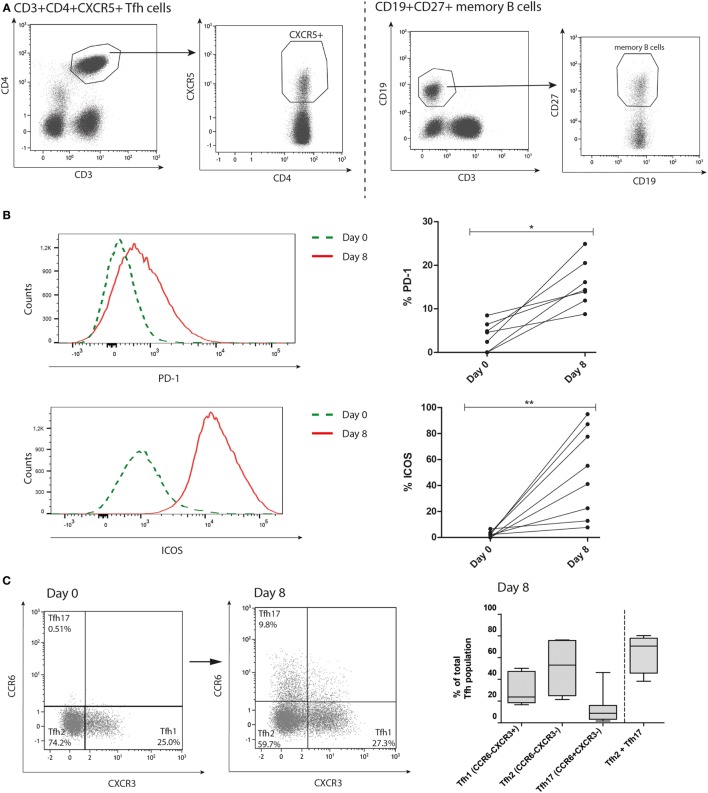
T follicular helper (Tfh) cells are activated upon stimulation with alloantigen. Tfh cells and memory B cells from patients, pre kidney transplantation, were stimulated with alloantigen and cocultured for 8 days. (A) Typical example of Fluorescence activated cell sorting gating strategy to obtain CD4posCXCR5pos Tfh cells and CD19posCD27pos memory B-cells. Cells were gated from viable (7-AAD negative) lymphocytes, defined by forward- and side-scatter. (B) Histogram overlays and quantified data of proportions programmed death 1 (PD-1) and inducible co-stimulator (ICOS) within CD4posCXCR5pos Tfh cells at baseline (day 0) and day 8 after coculture (PD-1 n = 7; ICOS n = 8). (C) Gating strategy and distribution of proportions CCR6negCXCR3pos Tfh1, CCR6negCXCR3neg Tfh2 and CCR6posCXCR3neg Tfh17 cells of the total Tfh population on day 0 and 8 after coculture. N.B.: box whiskers represent minimal and maximal values. The upper and lower borders of the box represent the 25 and 75% percentile, respectively, with the middle line representing the median (n = 8).